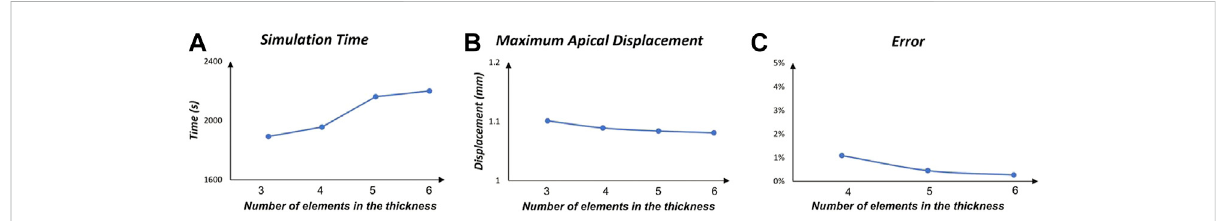
FIGURE 3 Meshsensitivityanalysis.Thegraphsarefunctionsofthenumberofelementsinthethickness. (A) Simulationtime; (B) Displacementoftheapex at the instant of maximum concavity; (C) Percentage error between consecutive mesh.